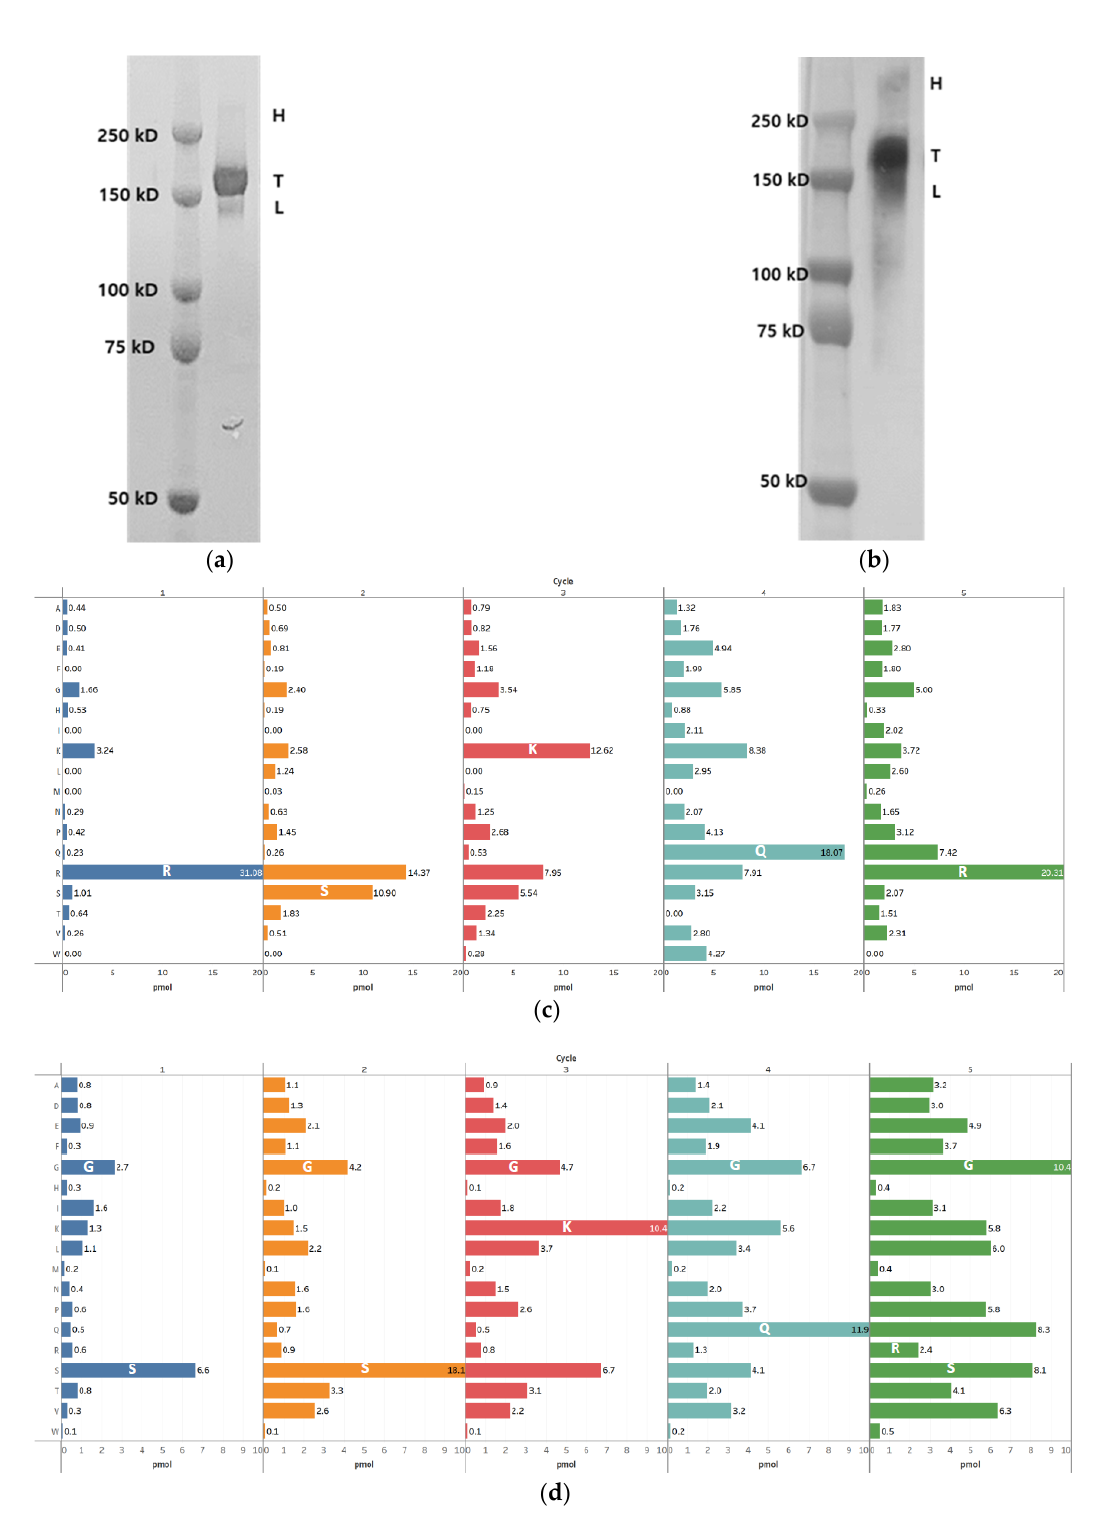
Figure 2. Purification and identification of peptide Fc-fusion proteins. ( a ) Eluted proteins after purification with Mabselect PrismA affinity chromatography were separated via SDS-PAGE without ß-mercaptoethanol (ME) and subjected to Coomassie blue staining. Band H: HMW proteins; band T: target protein; band L: LMW proteins. ( b ) The purified Fc-fusion proteins were identified through Western blot analysis with rabbit target protein antibodies followed by goat anti-rabbit IgG-AP conjugated. ( c ) Expected sequence in target protein tested by N-terminal sequencing (RSKQR). ( d ) Linker sequences such as SGGGG or GGGGS in LMW proteins were tested by N-terminal sequencing.